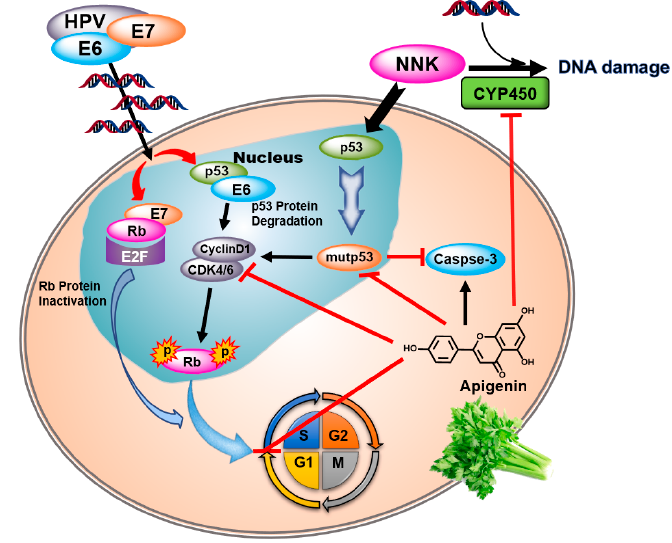
Figure 6. Molecular mechanism of AP inhibiting the synergistic carcinogenesis of HPV and NNK. The arrows and T-bars mean stimulation and inhibition, respectively.